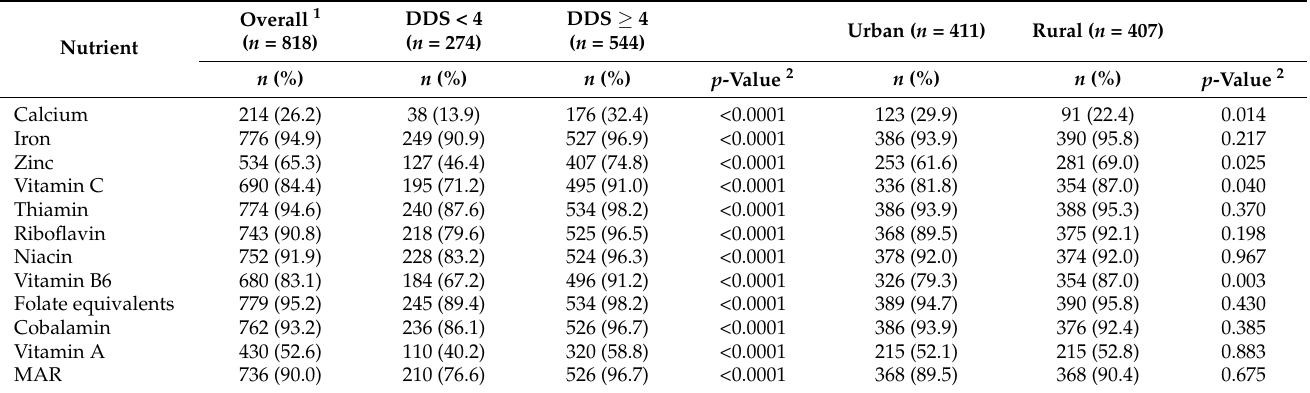
Table 6. Proportion of participants reaching Nutrient Adequacy Ratio (NAR) ≥ 0.70, according to Diet Diversity Score (DDS) and residence